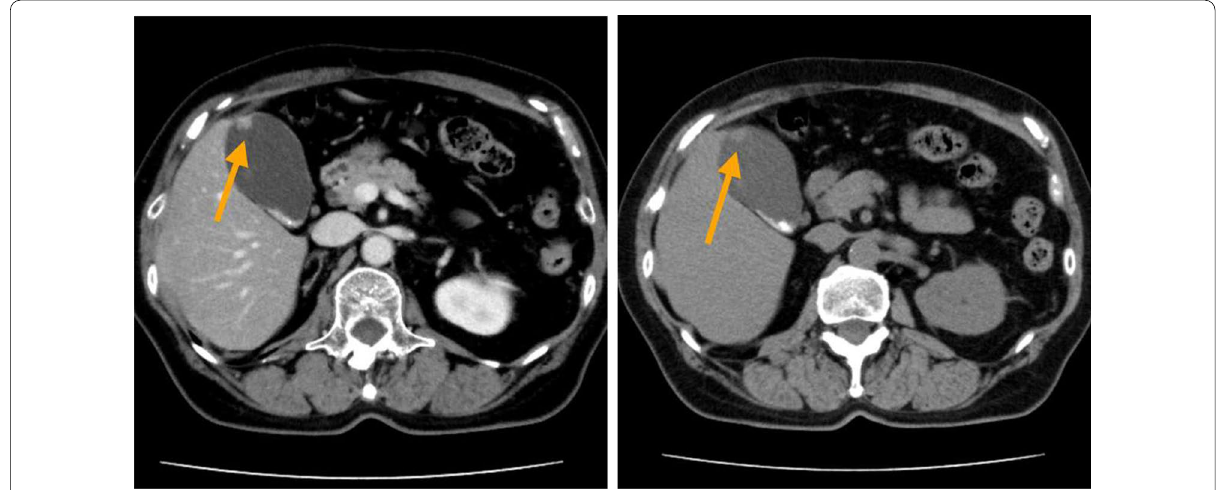
Fig.1 Abdominal computed tomography showed slightly enhanced tumor in the fundus of gallbladder (arrow)